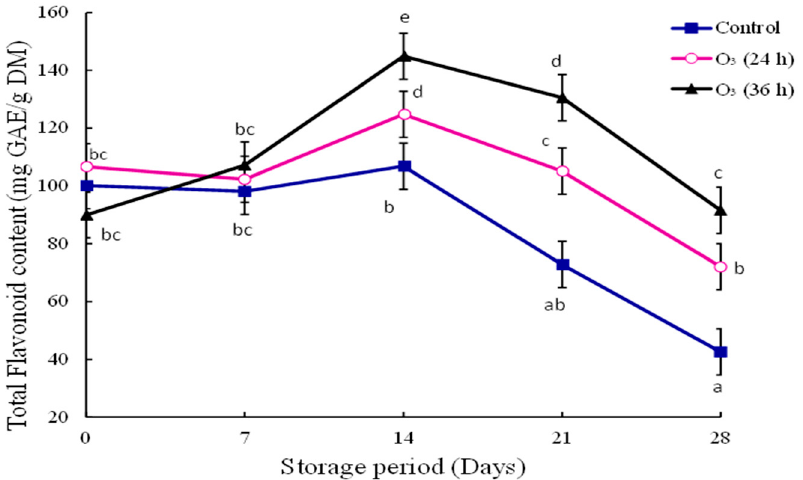
Figure 4. Effect of gaseous ozone (0.25 mg/L) on total flavonoid content of mango fruit inoculated with L. theobromae , stored at 10 ◦ C for three weeks and ripened at ambient temperature for seven days ( p < 0.05; ± SE; n = 9). The letters a–e are used above or below the reported values. The means with the same letter are not significantly different (least significant difference =